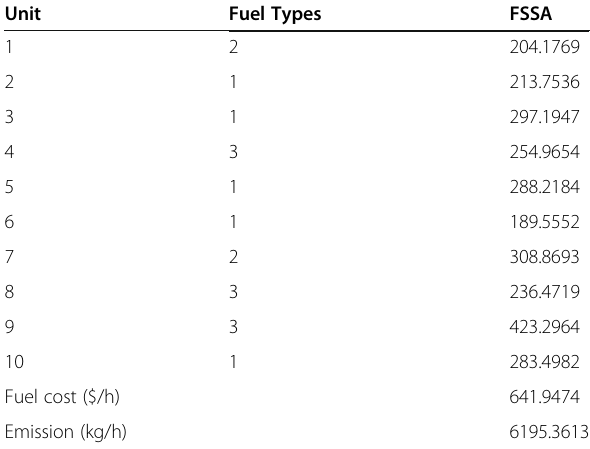
Table 5 BCS acquired by the FSSA approach Unit